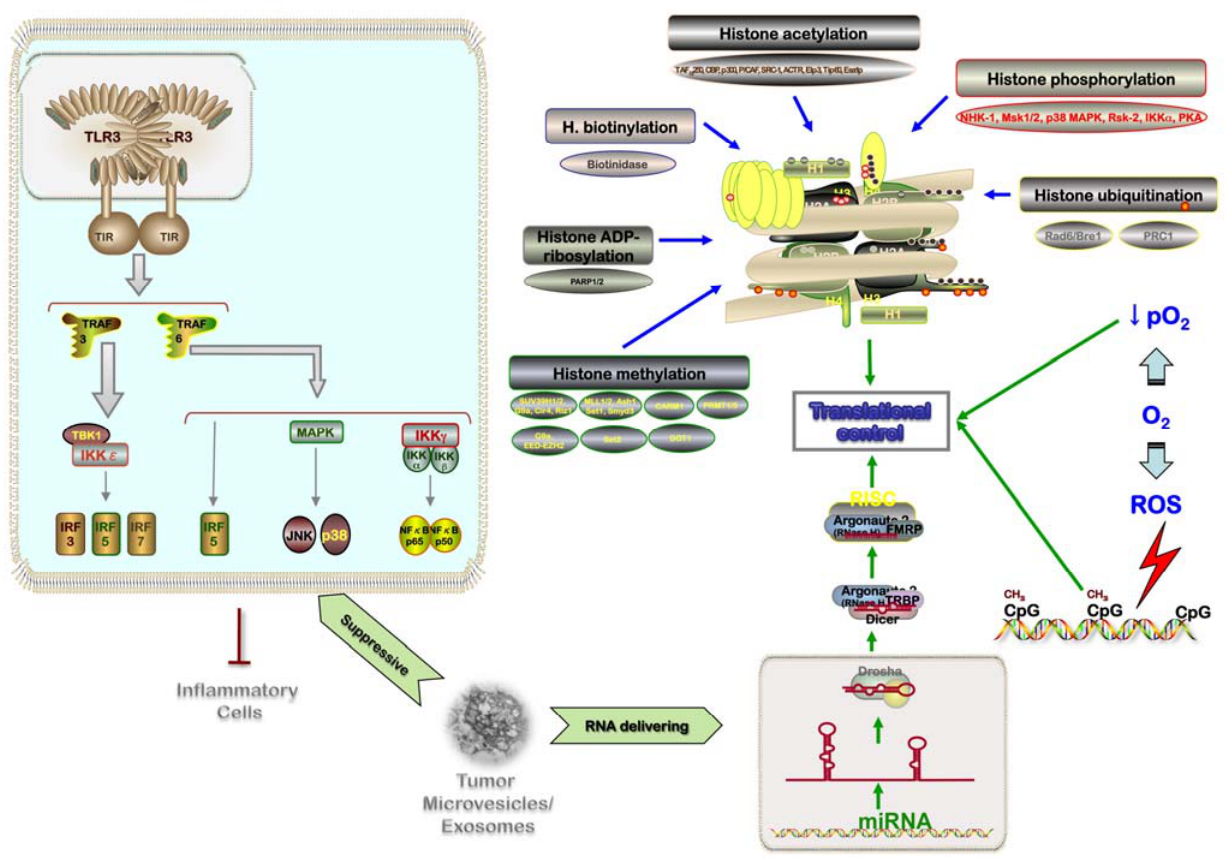
Figure 4. Differential gene regulation in neoplasms. This process is related with extracellular suppressive mechanisms and RNA delivering through exosomes, hypoxic microenvironment, and epigenetics (methylation and histone